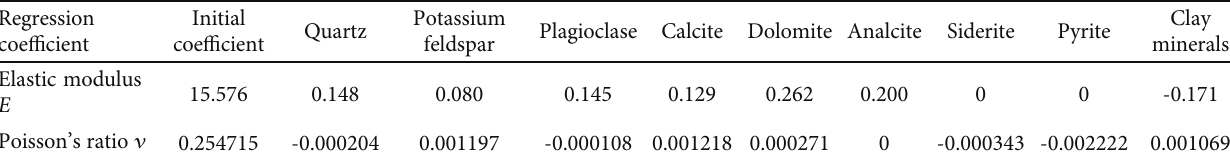
Figure 6: Experiment with loading devices and processes. Table 2: Multiple linear regression analysis